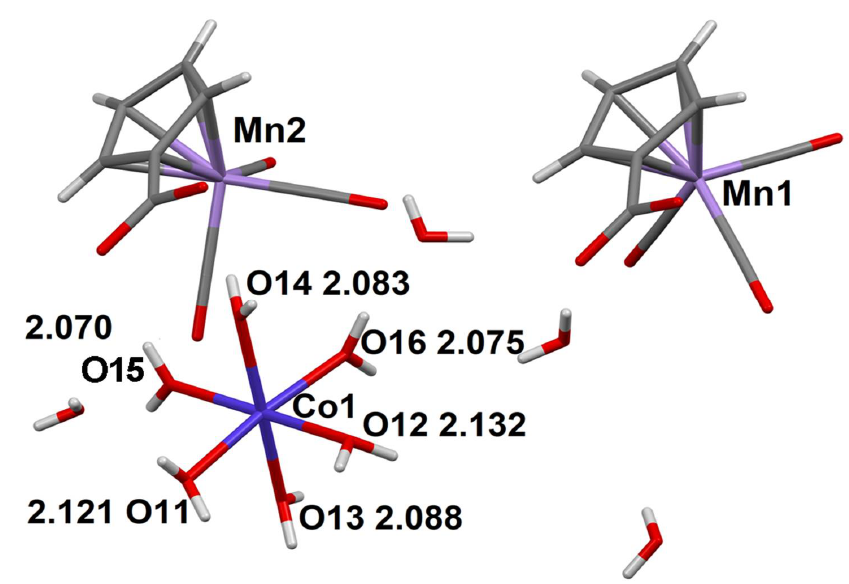
Figure 1. Asymmetric unit in the structure of compound 1 . The distances between the coordinating oxygen atoms of aqua ligands and the Co 2+ ion are given (Å).